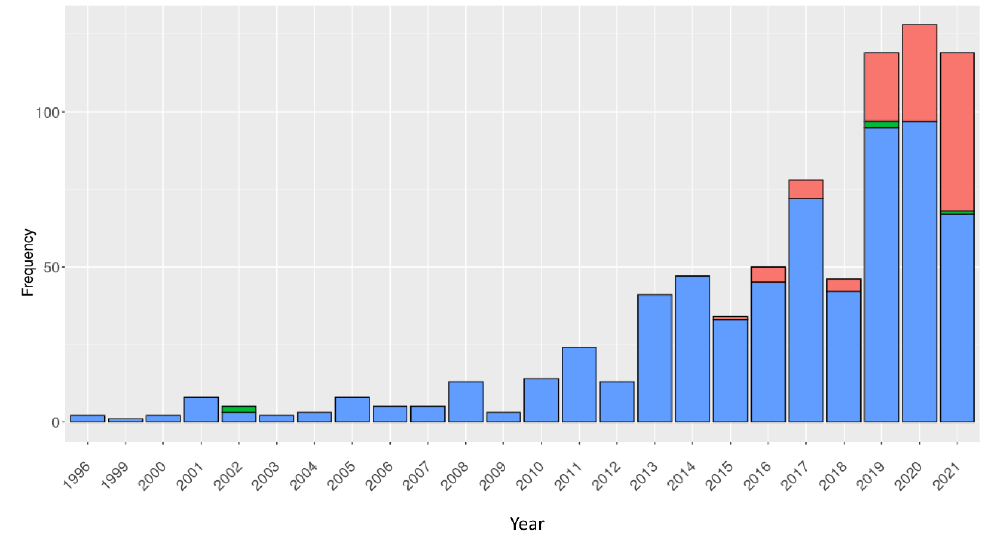
Figure A1. Number of V H H structures deposited in the PDB per year. Structures solved using different experimental methods are colour-coded accordingly (our own analysis) (electron microscopy, solution NMR and X-ray diffraction has been represented in red, green and blue respectively). It differs from Figure 4, as only nonmodified camelid V H Hs were